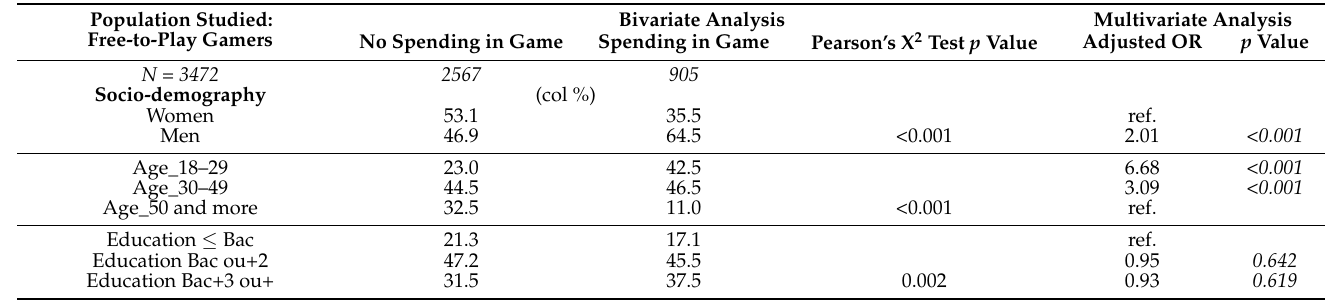
Table 2. Spending in game—multifactorial predictive